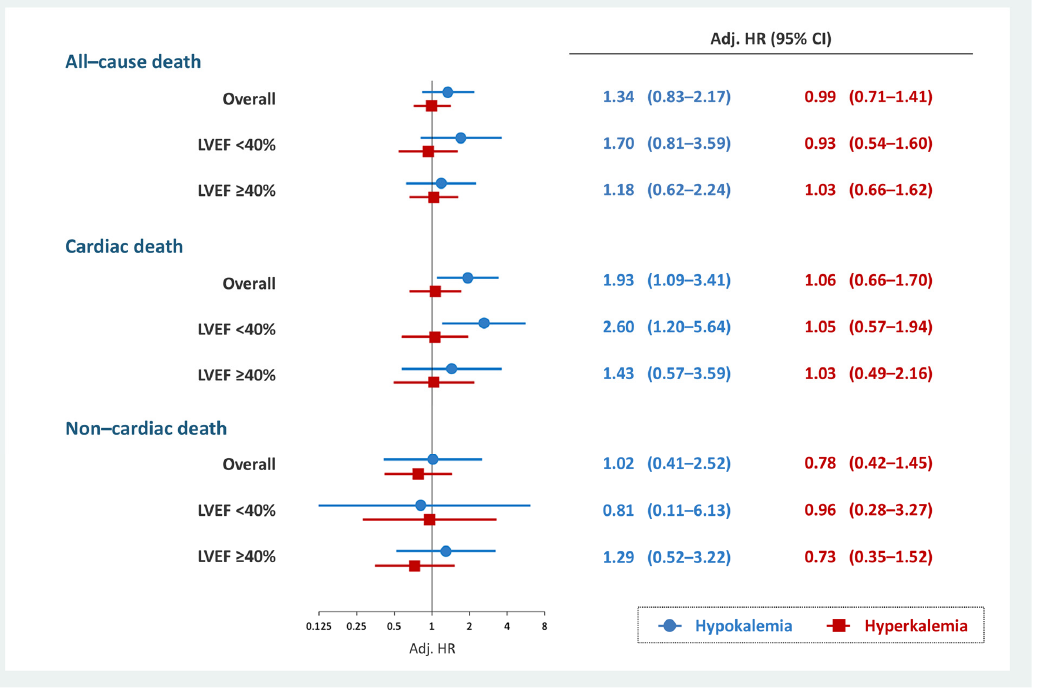
Figure 2. Multivariate Cox regression analysis for each prognosis and dyskalemia. Hypokalemia was significantly associated with 2-year cardiac death in patients with HFrEF but not in those with non-cardiac death. Hyperkalemia was not associated with prognosis. Models were adjusted for age, COPD, ischemic heart disease, eGFR at discharge, combination medical therapy, high-dose loop diuretics, thiazide diuretics, New York Heart Association functional class III/IV, and cachexia. CI, confidence interval; COPD, chronic obstructive pulmonary disease; eGFR, estimated glomerular filtration rate; HFrEF, heart failure with reduced ejection fraction; HR, hazard ratio; LVEF, left ventricular ejection fraction.